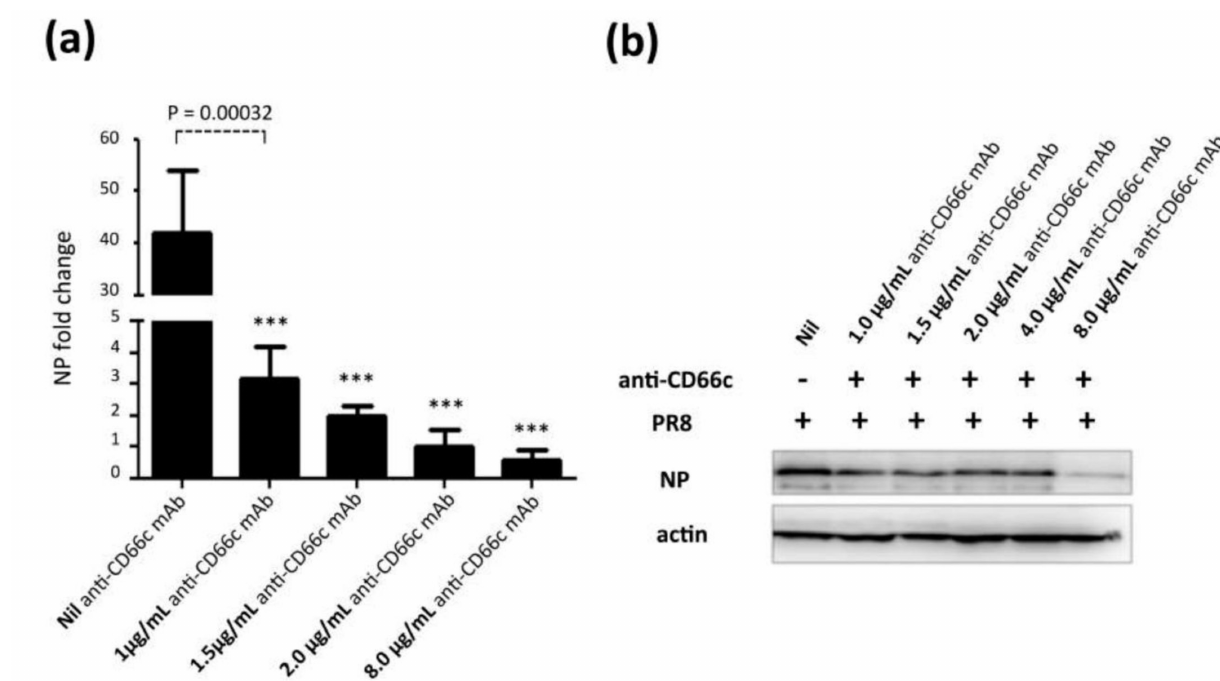
Figure 6. Antibody mediated receptor blockade experiments in CD66c overexpressing cells. ( a ): The figure shows level of A/PR8/34 influenza virus entry in a monolayer of NIH3T3-CD66c cells when treated with mAb anti-CD66c prior to infection. From left to right, the first bar in the figure represents levels of viral NP mRNA (a measure of virus entry) in untreated NIH3T3-CD66c. Bars second to fifth from left show levels of viral NP mRNA in virus-infected cells treated with mAb anti-CD66c at a concentration of 1.0 µ g/mL, 1.5 µ g/mL, 2.0 µ g/mL and 8.0 µ g/mL respectively. Conclusively, the data show a decrease in virus entry in cells treated with anti-CD66c in a dose dependent manner. Data represent mean values of at least three independent experiments ± SD. Statistical significance was assessed by student’s t -test (GraphPad), (*) for p ≤ 0.05, (**) for p ≤ 0.01 and (***) for p ≤ 0.001. ( b ): A western blot showing expression levels of viral NP protein in virus-infected NIH3T3-CD66c when treated with corresponding concentrations of mAb anti-CD66c 1.0 µ g/mL, 1.5 µ g/mL, 2.0 µ g/mL, 4.0 µ g/mL and 8.0 µ g/mL, prior to viral infection. The inhibition of virus entry in anti-CD66c mAb treated cells was significant at a concentration of 8.0 µ g/mL of